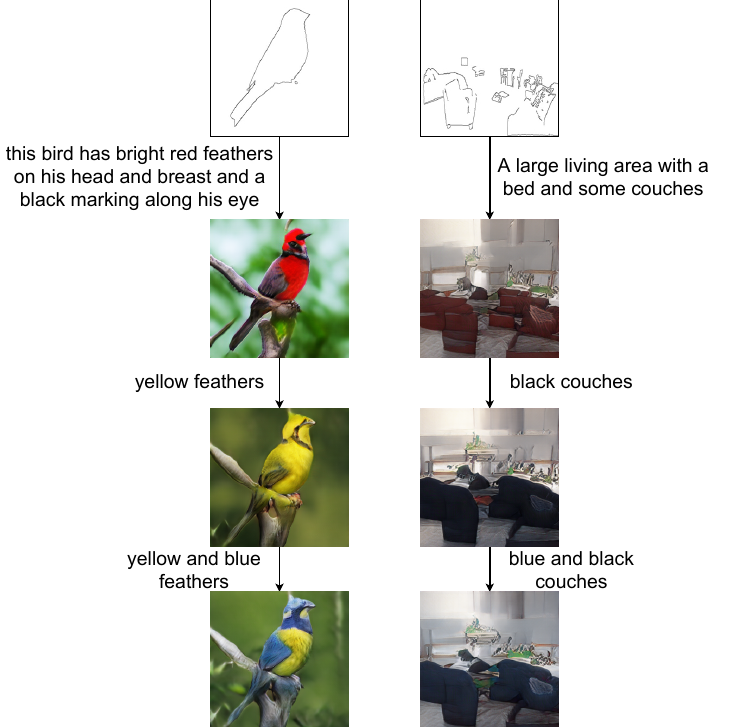
Figure 5. The above figure shows the results of image synthesis and manipulation based on text guidance. First, the image content was generated based on the text and contour information, and then the content of the synthesized image could be modified continuously by inputting the text of the object’s attributes.